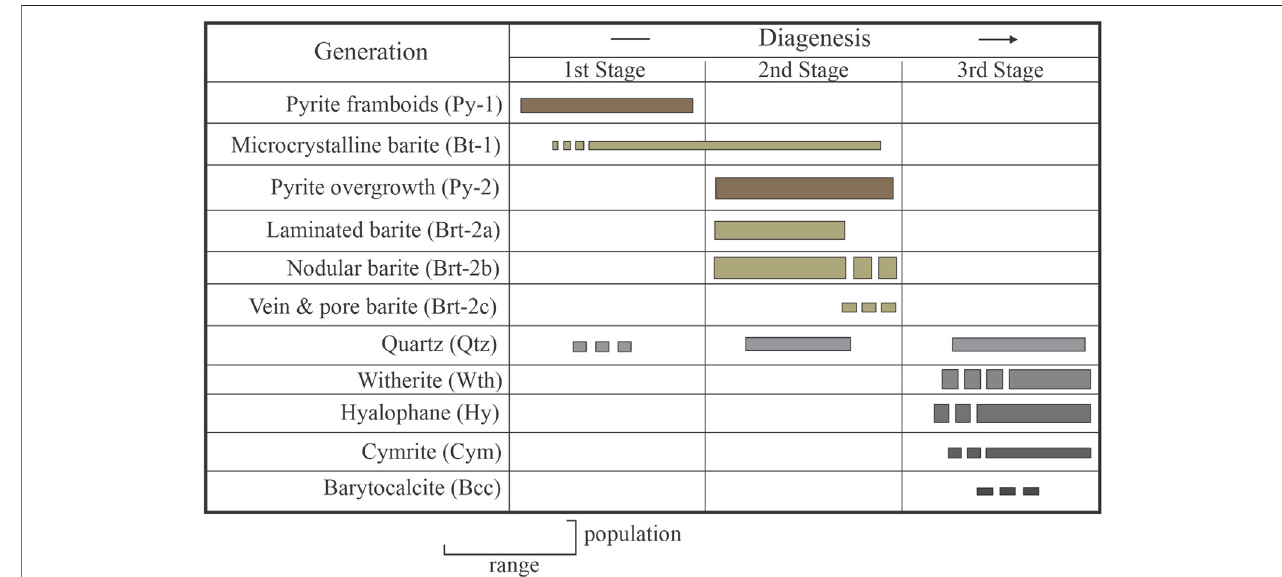
FIGURE 5 | Simpli fi ed paragenetic succession of main pyrite and barite generations.